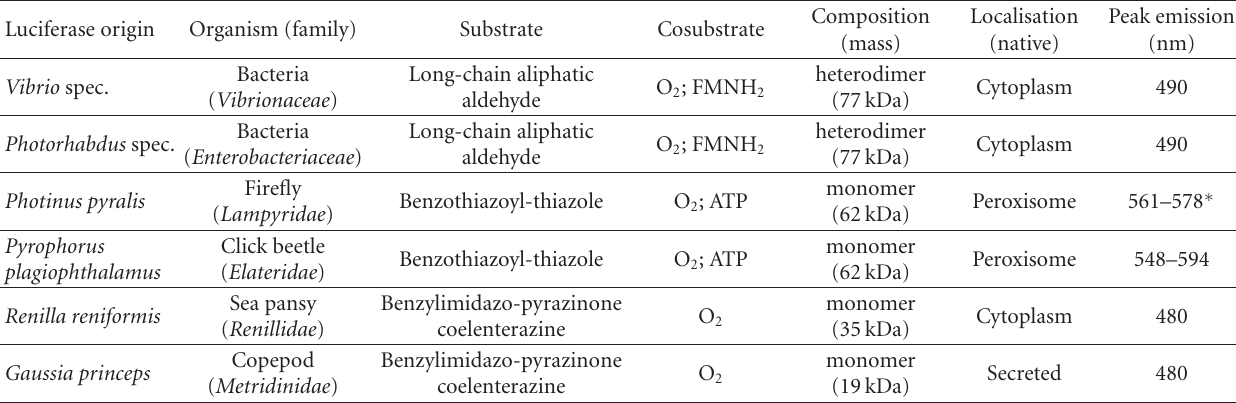
Table 1: Key features of selected luciferases from di ff erent phylogenetic